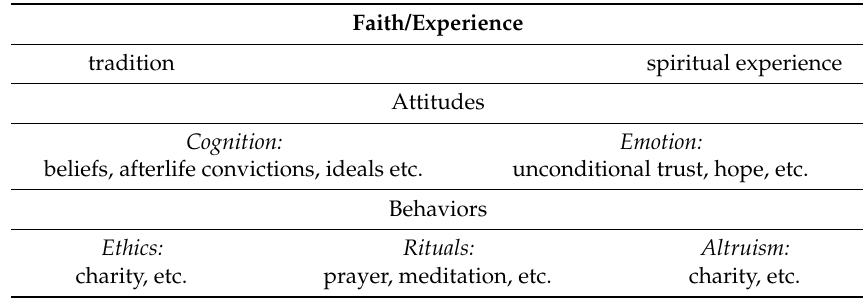
Table 1. Schematic levels of representation of different ‘layers’ aspects of spirituality (modified according to Büssing